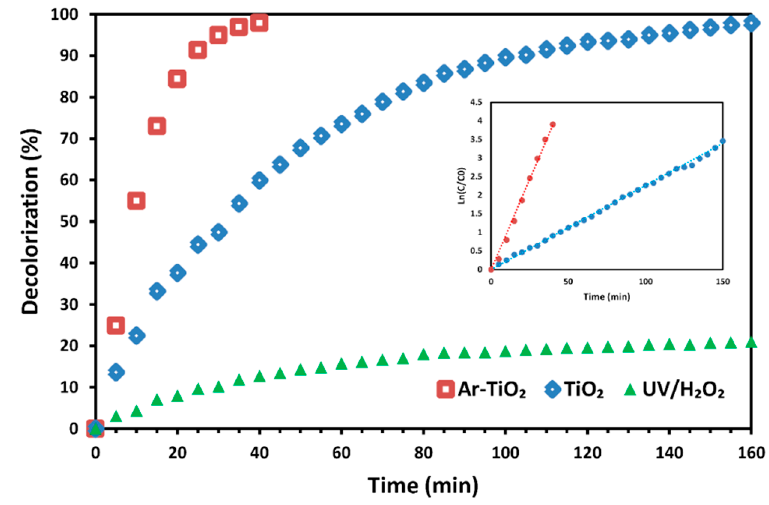
Figure 8. MG decolorization efficiency of plasma-treated and non-treated TiO 2 nanoparticles immobilized on glass plates; initial reaction conditions: [MG] = 10 mg/L and [H 2 O 2 ] = 13 mM.